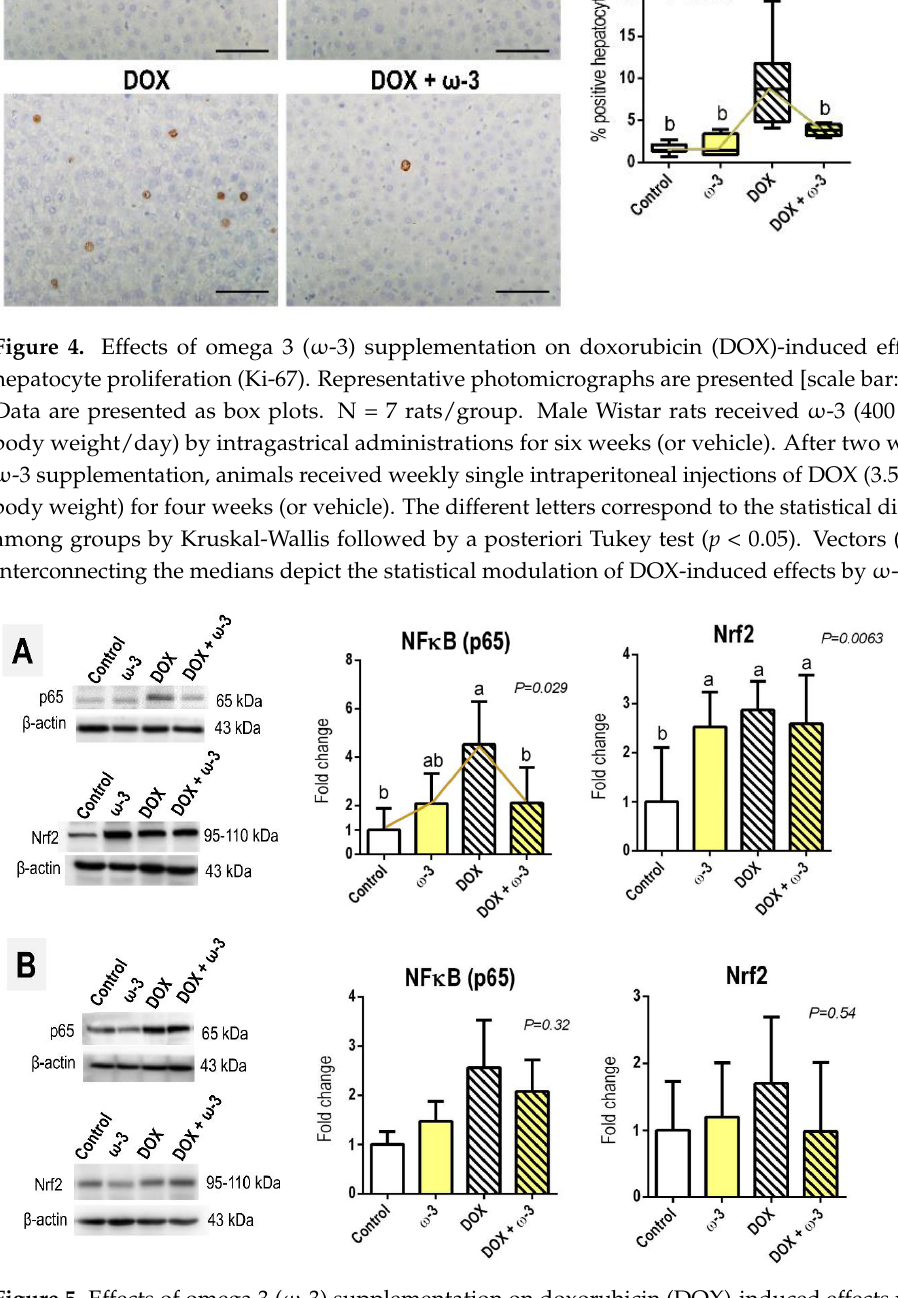
Figure 5. Effects of omega 3 (ω-3) supplementation on doxorubicin (DOX)-induced effects p65 and Nrf2 protein levels in the ( A ) liver and ( B ) kidney. Representative blot bands are presented. Data are presented as mean and standard deviation. N = 6 rats/group. Male Wistar rats received ω-3 (400 mg/kg body weight/day) by intragastrical administrations for six weeks (or vehicle). After two weeks of ω-3 supplementation, animals received weekly single intraperitoneal injections of DOX (3.5 mg/kg body weight) for fr weeks (or vehicle). The different letters correspond to the statistical difference among groups by one-way ANOVA followed by a posteriori Tukey test ( p < 0.05). Vectors (yellow) interconnecting the medians depict the statistical modulation of DOX-induced effects by ω-3.